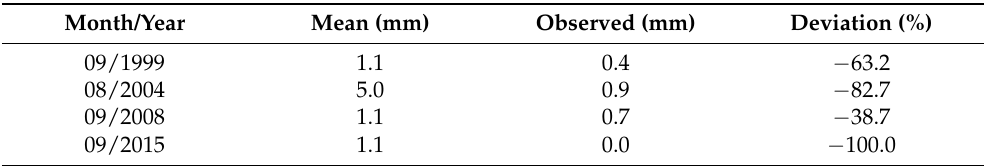
Table 1. Mean and observed rainfall for August and September months over the LJRSB during the studied years.